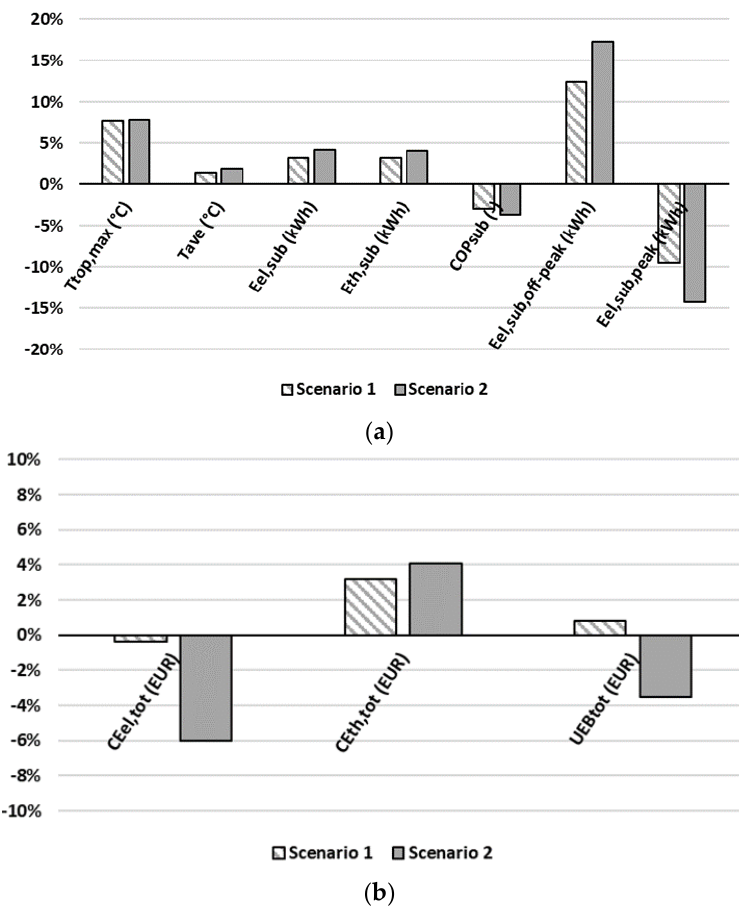
Figure 13. Energy ( a ) and economic ( b ) relative variations of the ETS operation with respect to the baseline.